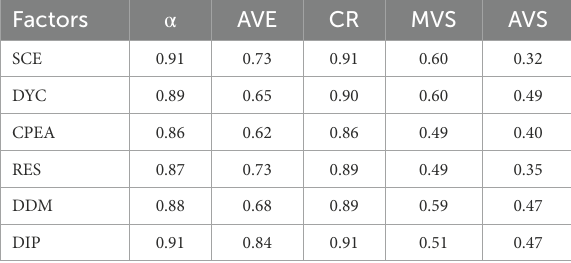
TABLE 5 Convergent and discriminant validity